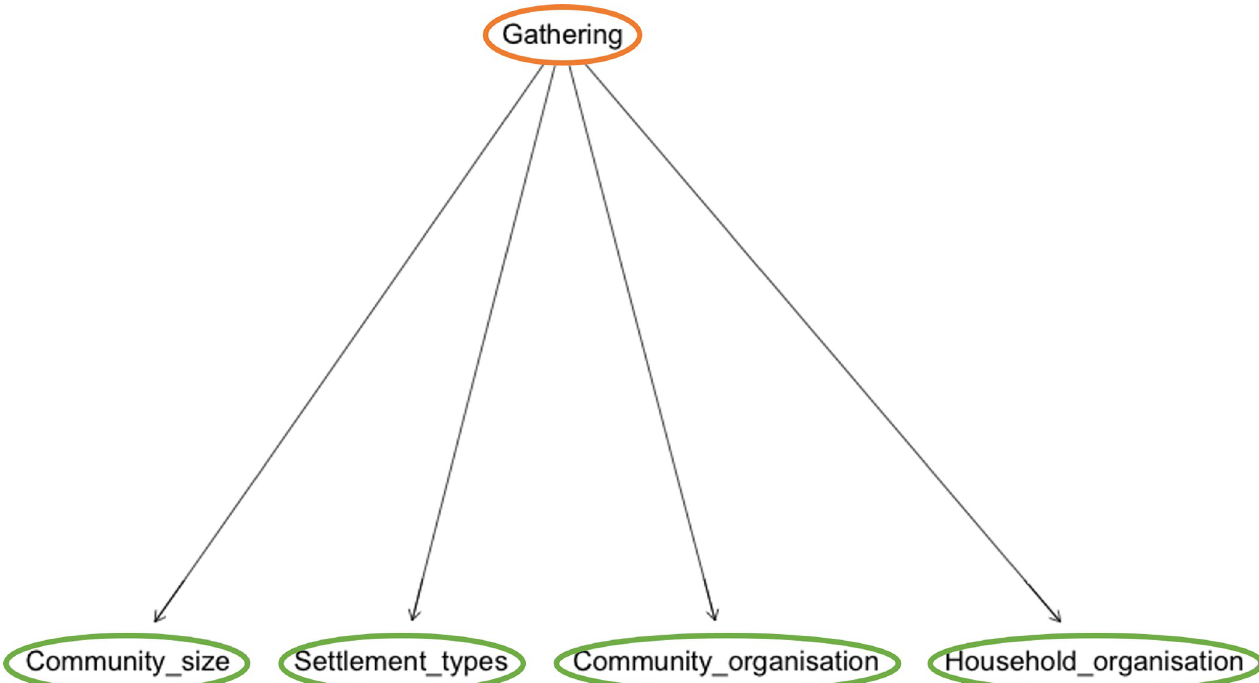
Fig 9. Model A-ANB exploring the relationship between social organisation and subsistence strategies. Dependence between social organisation (inputs, green) and gathering (output, orange). The absence of relationship among input variables is present in all the BNs produced for all the outputs examined.